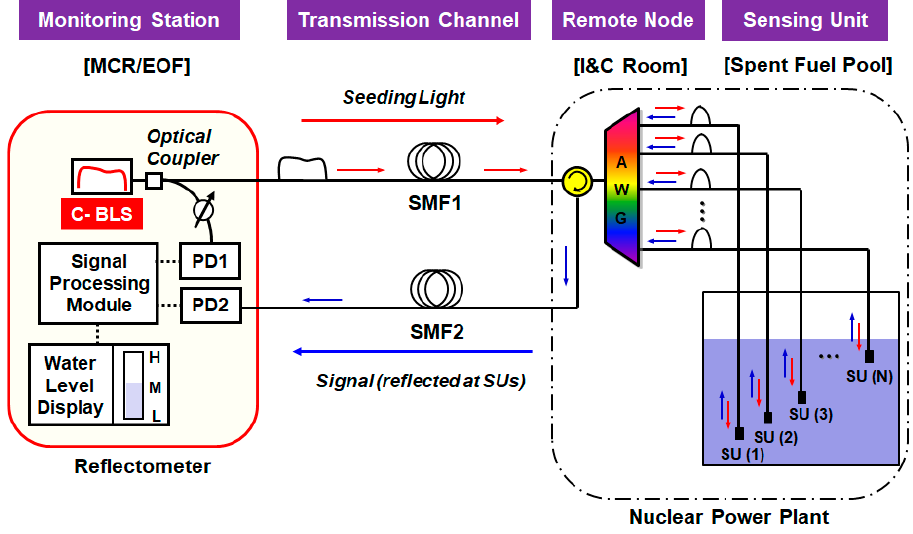
Figure 6. Simulation and measurement results at the different distances in the single-path configuration network. ( a ) The spectra of 1/2 water level at 5 km, ( b ) the spectra of 1/2 water level at 10 km, ( c ) the spectra of 1/2 water level at 20 km, and ( d ) optical-received power as a function of the water level.